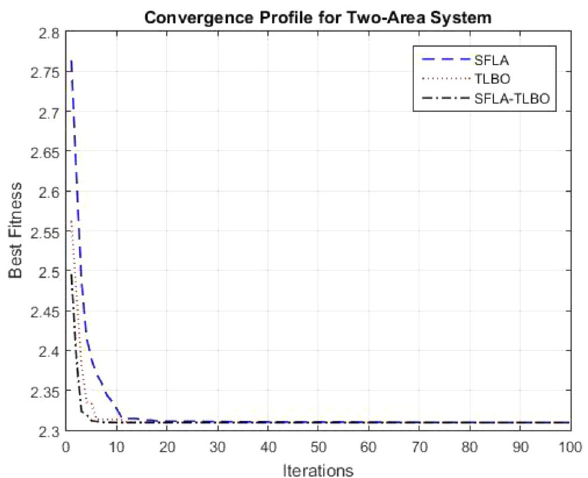
Fig. 5 Convergence profile for two-area system Fig. 6 Convergence profile for two-area system